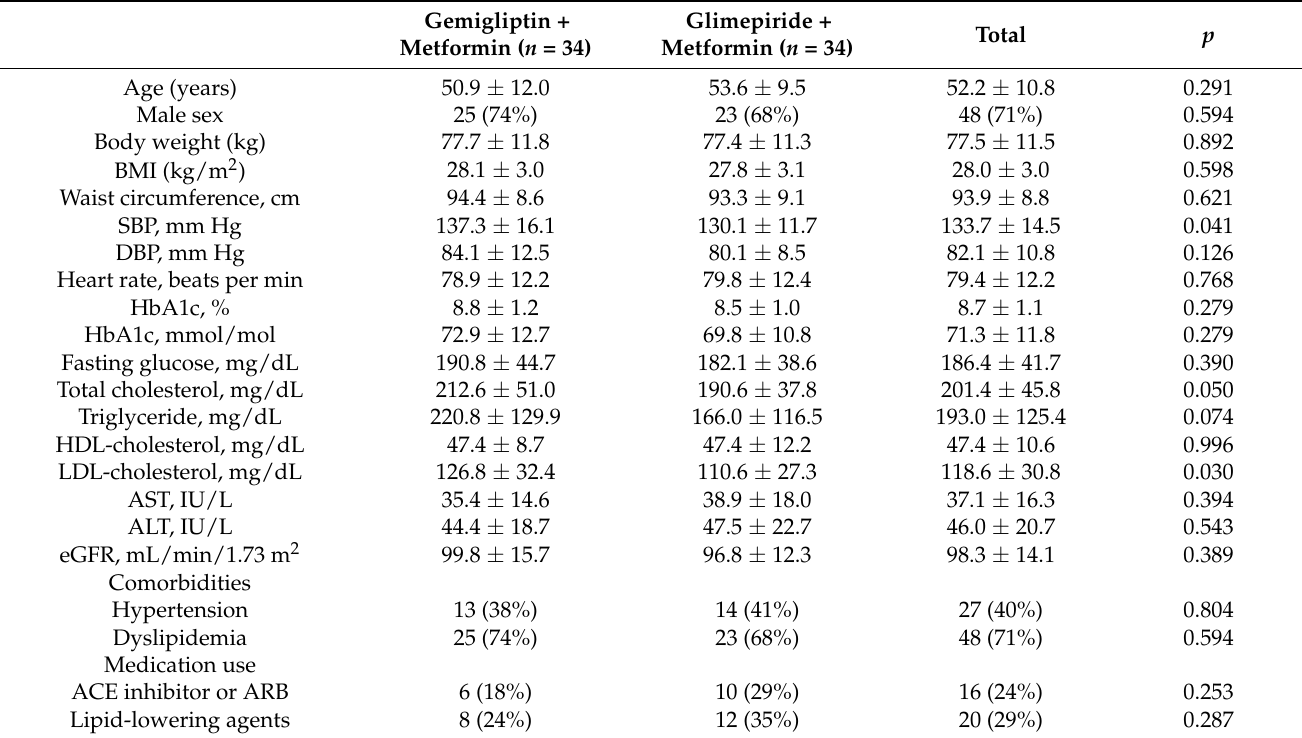
Table 1. Baseline characteristics of the intention-to-treat study